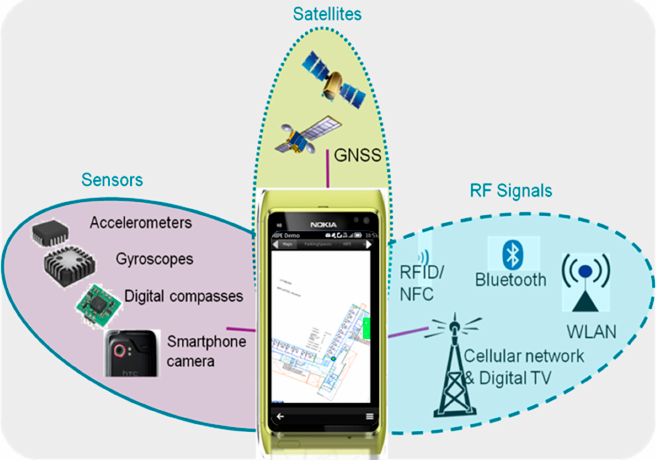
Figure 1. Location and motion state sensing using measurements of versatile signals and sensors available from a